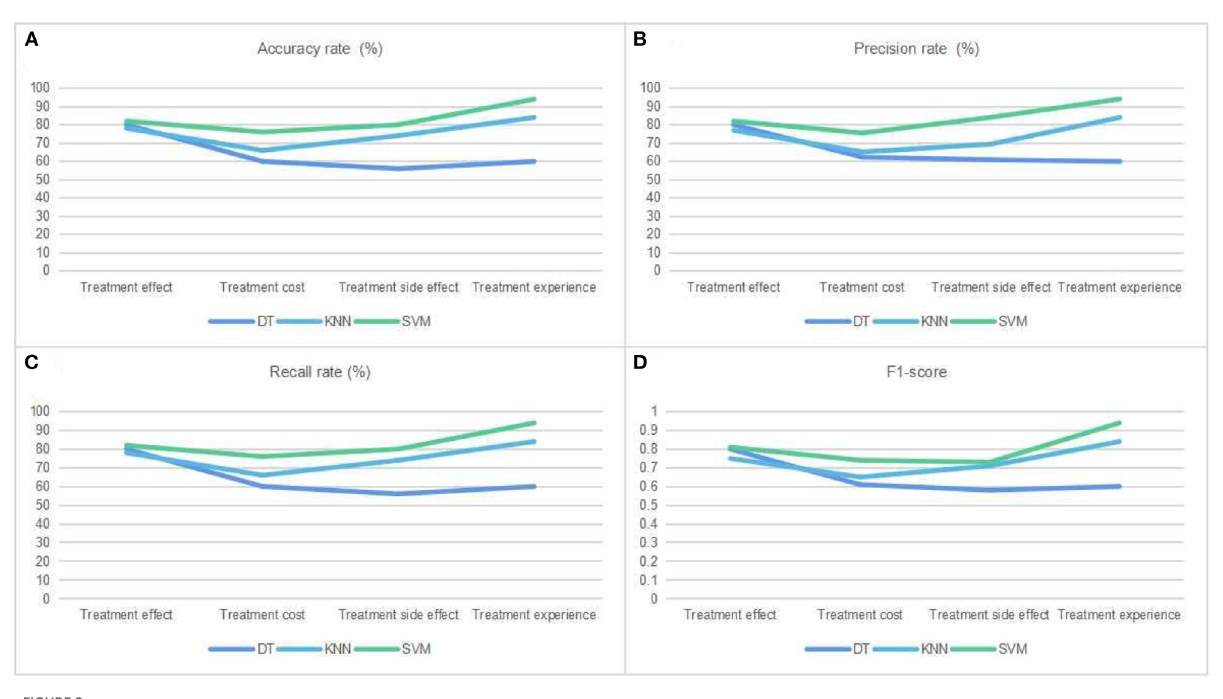
FIGURE2 Performance comparison of three kinds of classification algorithms. (A) The accuracy rate of patients’ medical decision selection tendency was predicted by three ML classification algorithms: decision tree (DT), k-nearest neighbor (KNN), and support vector machine (SVM). (B) Same as (A) , but for precision rate. (C) Same as (A) , but for recall rate. (D) Same as (A) , but for